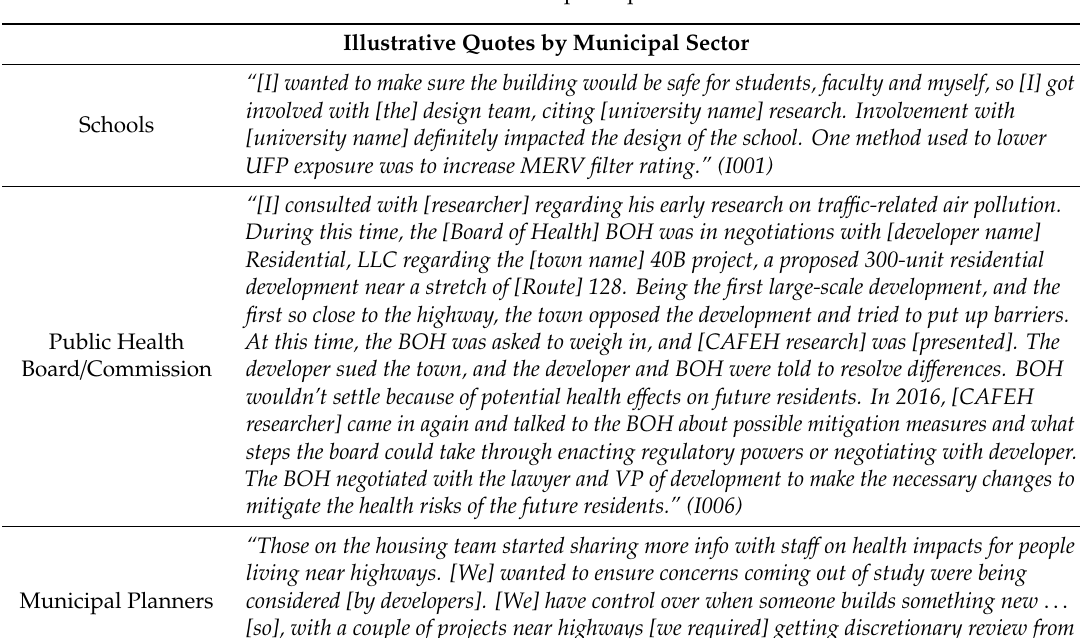
Table 3. Municipal